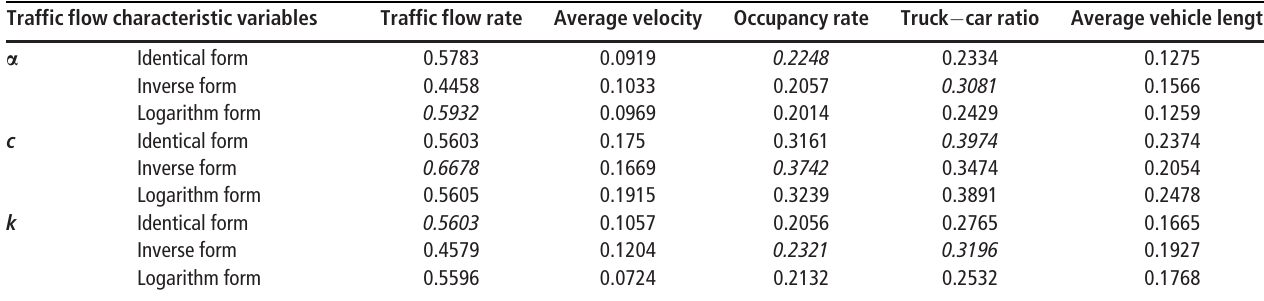
Table 2 Mean value of variable importance Traffic flow characteristic variables